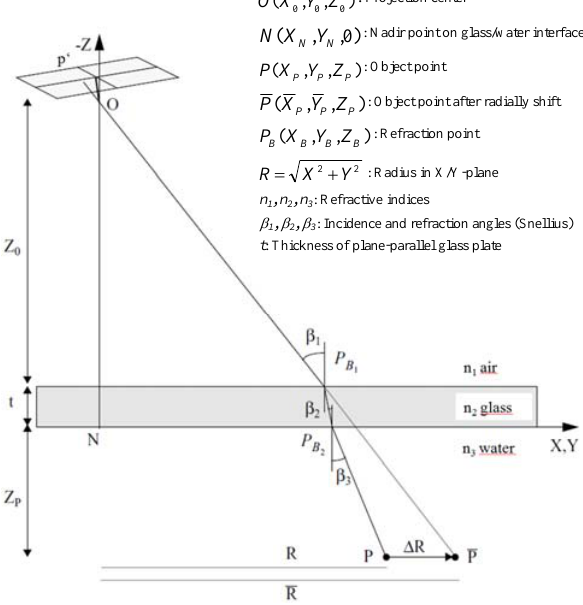
Figure 1. Radial shift for multi-media effect compensation (Maas,